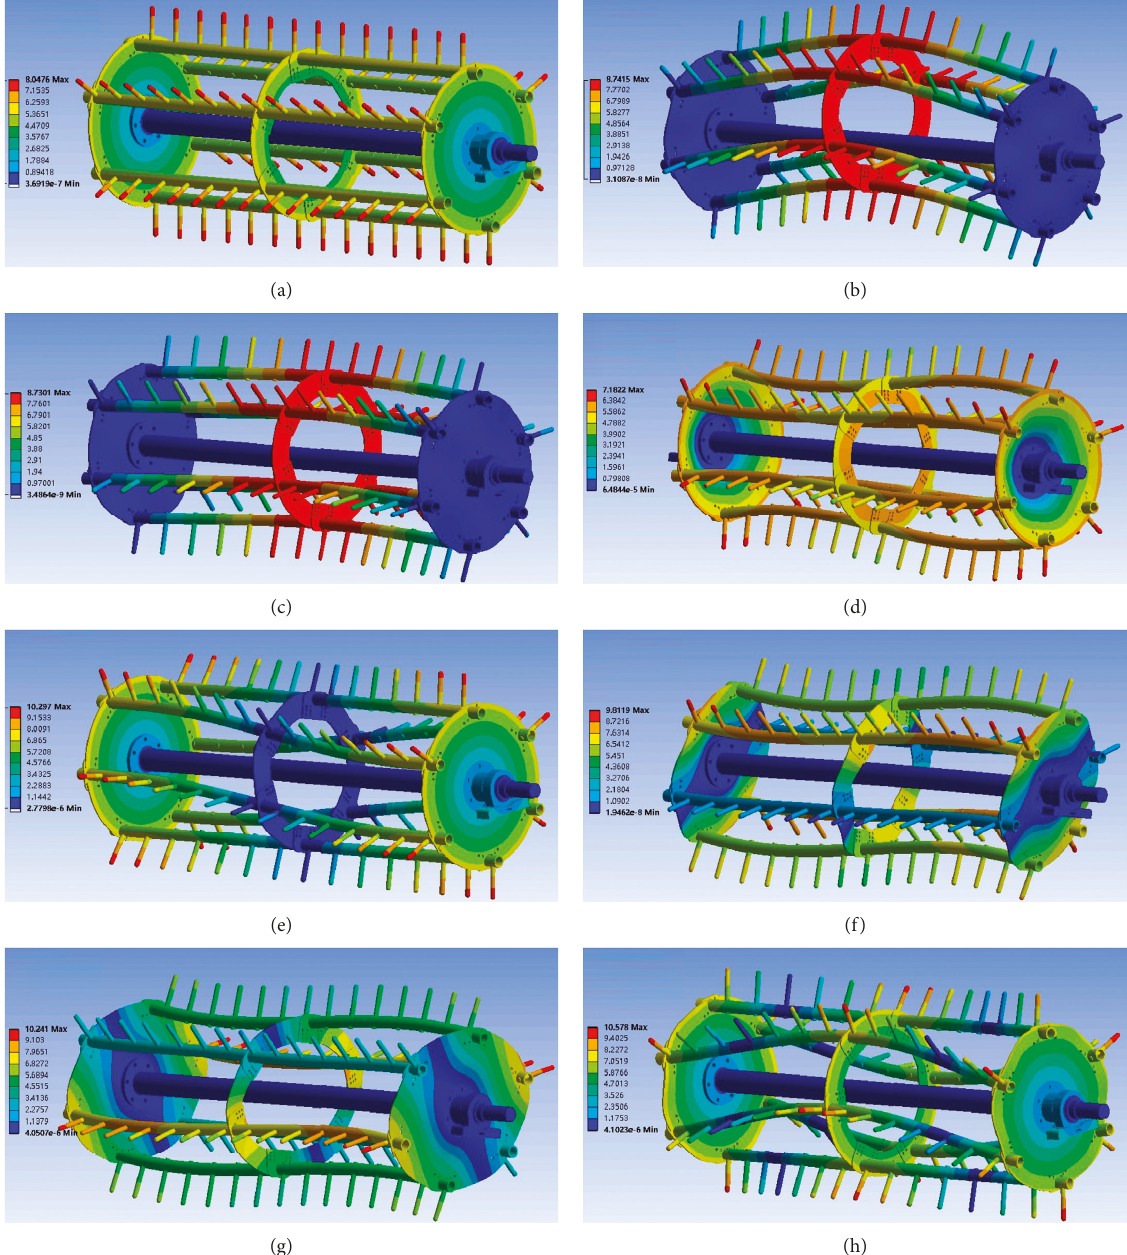
Figure 6: Vibration mode shapes under the no-load state. (a) 1st order mode. (b) 2nd order mode. (c) 3rd order mode. (d) 4th order mode. (e) 5th order mode. (f) 6th order mode. (g) 7th order mode. (h) 8th order